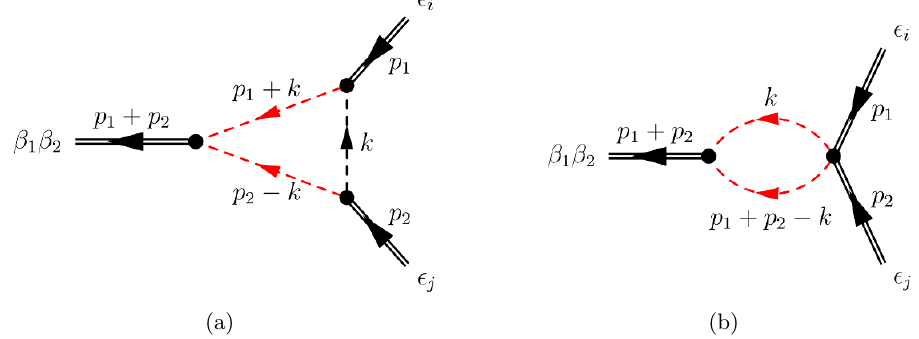
Figure 4 . Feynman diagrams for the three-point function h T (cid:12) 1 (cid:12) 2 j T[ ~ T i ( p 1 ) ~ T j ( p 2 )] j 0 i in the free scalar theory. Here we use straight double lines for T operators and dashed singled lines for scalars. Red lines indicate Wightman propagators, black lines ordinary Feynman propagators.